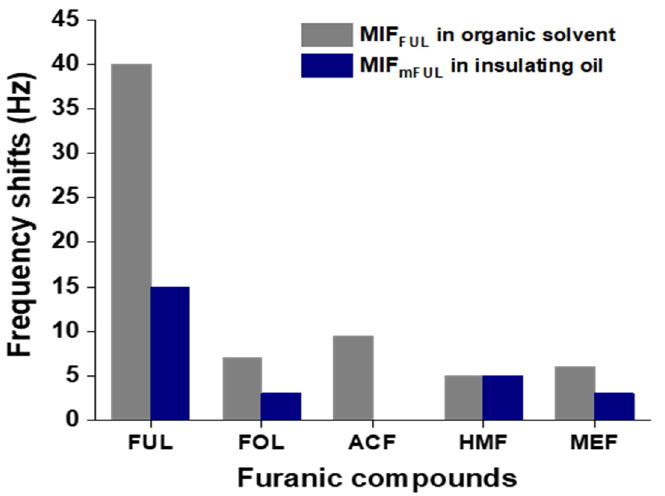
Figure 6. The frequency-shift results for furanic compounds by comparing MIFm-QCM sensors with insulating oil and MIF-QCM sensors in organic solvents. A mixture solution of heptane/acetone (95/5, v / v ) was used for circulating in MIF-QCM sensors. FUL = 2-furaldehyde; FOL = 2-furfuryl alcohol; ACF = 2-acetylfuran; HMF = 5-hydroxymethyl-2-furaldehyde; MEF = 5-methyl-2-furaldehyde; MIF m = imprinted film with Methacr- L -Ser-NHBn.